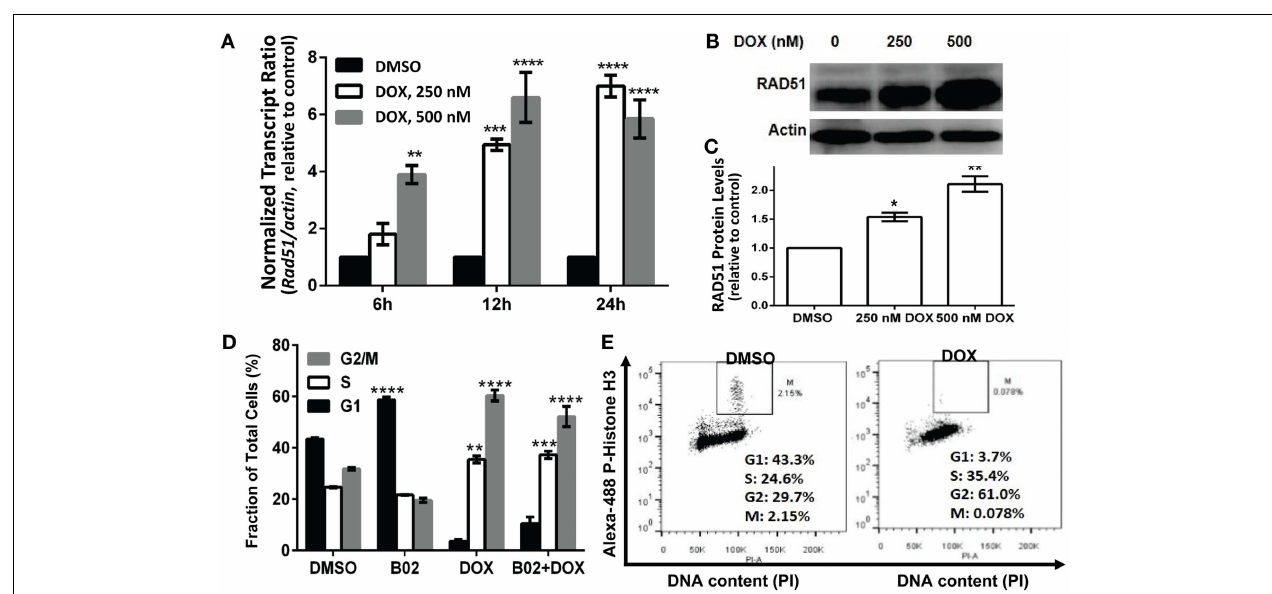
mean ± SEM (* p < 0.05 or ** p < 0.01 relative to vehicle treatment alone). (D) Shift in cell-cycle distribution, indicating arrest in S and G2 phases, determined by FACS analysis of relative DNA content per cell (based on fluorescence of DNA with intercalated propidium iodide, in permeabilized cells). Mean values ± SEM are shown for triplicate treatments per experiment for 2–3 biological replicates (total n = 6 or 9). Unadjusted significance of differences, relative to the same cell-cycle phase of cells exposed only to DMSO: * p < 0.05; ** p < 0.01; *** p < 0.001; **** p < 0.0001. (E) Cells treated with DOX or vehicle were stained with propidium iodide and Alexa Fluor 488-conjugated antibody to phosphorylated (ser10) histone H3, to determine the fraction of G2/M-arrested cells that are in mitosis